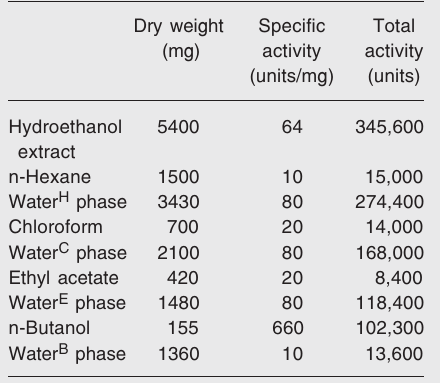
Figure 6. Titration of the hemo- lytic effect of the Passiflora quadrangularis hemolysin with cholesterol. Phosphatidylcho- line/cholesterol liposomes were two-fold serially diluted on mi- croplates and mixed with a fixed amount (0.1 mg dry weight) of the hemolysin and the erythro- cyte suspension was then added. Hemolysis was quanti- fied following incubation for the time given in figure. The hemo- lysin/cholesterol ratio (w/w) is given on the abscissa. The ar-